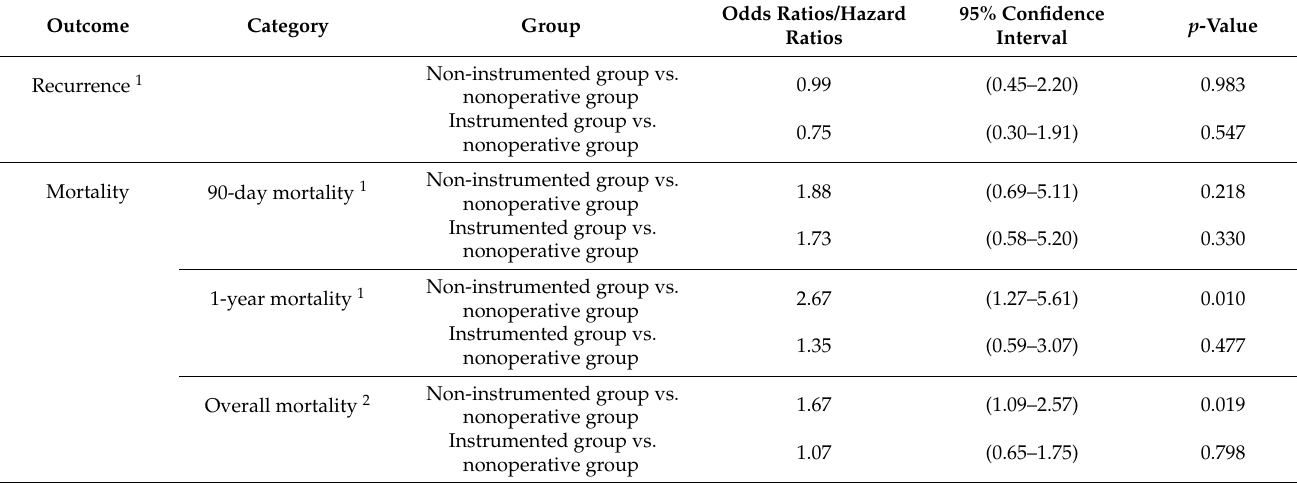
Table 3. Comparison of treatment outcome according to the three treatment groups in the whole cohort: multivariable analysis. Outcome